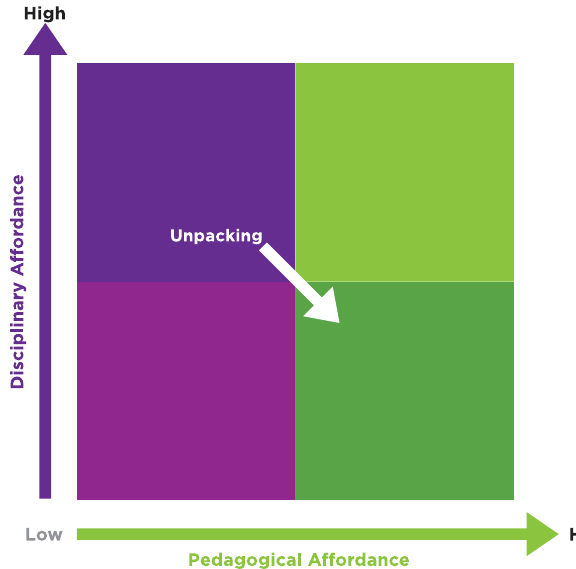
FIG. 38. The idea of unpacking representations. Adapted from the work of Airey and Eriksson